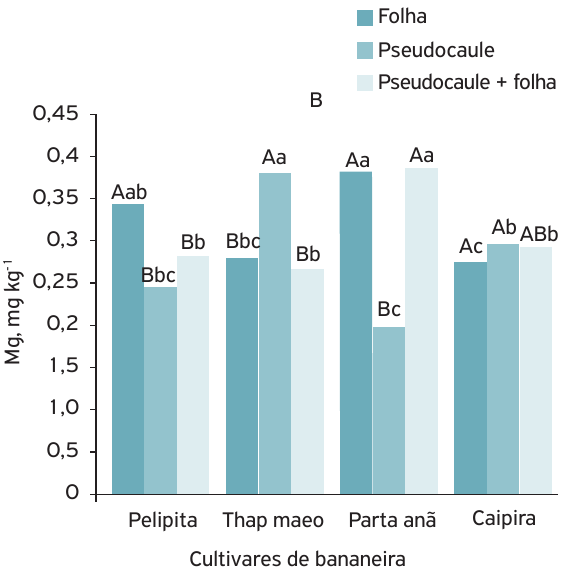
Figura 12. Teores de Mg, %, presente no substrato à base de resíduos (pseudocaule, folha e pseudocaule + folha) (A) de quatro cultivares de bananeira (Thap maeo, Prata anã, Pelipita e Caipira) após a sua colonização pela linhagem 09/100 de Pleurotus ostreatus . Letras maiúsculas comparam médias dentro de um mesmo cultivar de bananeira; letras minúsculas comparam médias dentro de cada tipo de resíduo. Médias seguidas de letras iguais não diferem entre si (Tukey,